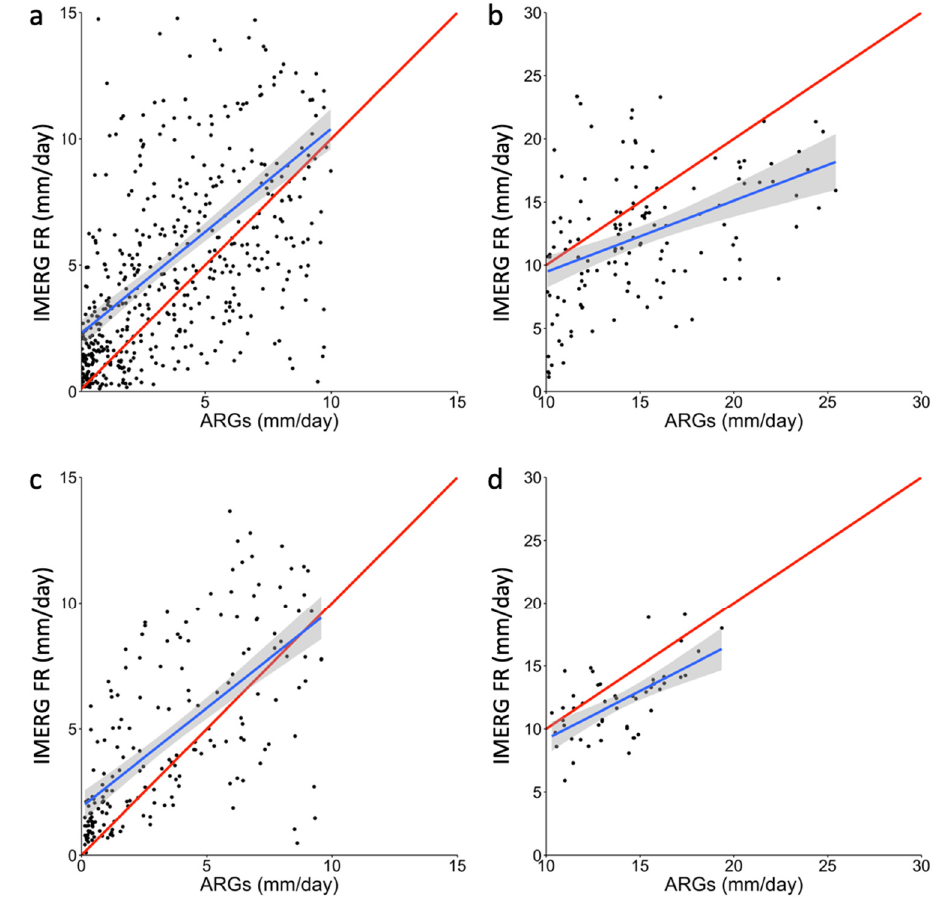
Figure 11. Comparison of IMERG FR and ARGs 10 day rainfall at ( a ) ≤ 10.0 mm/day and ( b ) >10.0 mm/day. Plots ( c ) to ( d ) are comparisons at similar rainfall intervals for monthly rainfall.